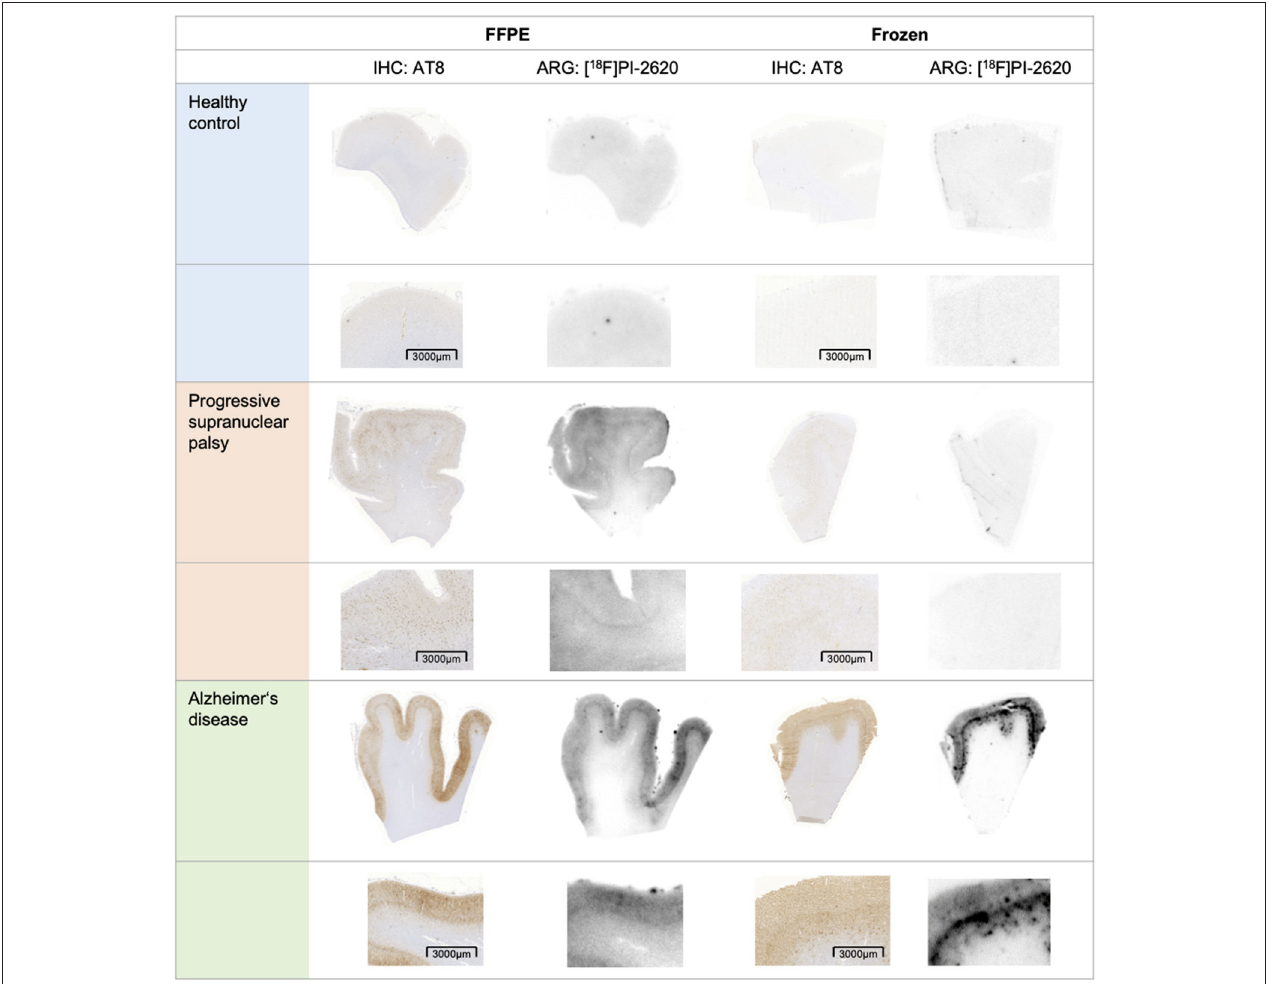
FIGURE 2 | Exemplary tau-immunohistochemistry (left corresponding sections) and autoradiography (right corresponding sections) of frontal cortex sections of both tissue types (FFPE on the left, frozen on the right) in a healthy control (both no. 15), progressive supranuclear palsy (both no. 8) and Alzheimer’s disease (FFPE: no. 4, frozen: no. 3). Upper row: section overview, lower row: zoom. FFPE, formalin-fixed paraffin-embedded; IHC, immunohistochemistry; ARG, autoradiography.